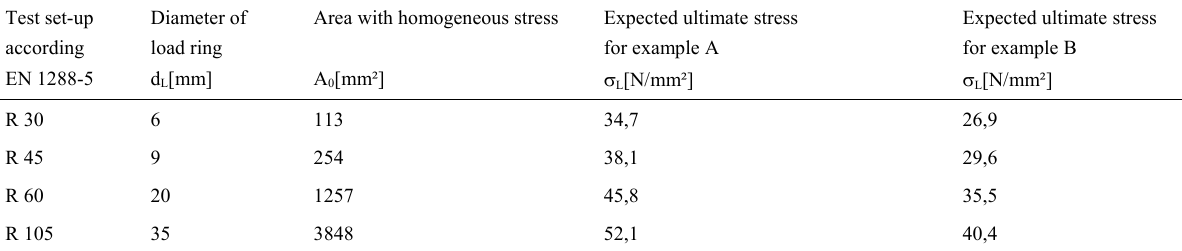
Table 1: Expected ultimate stress for example A and B